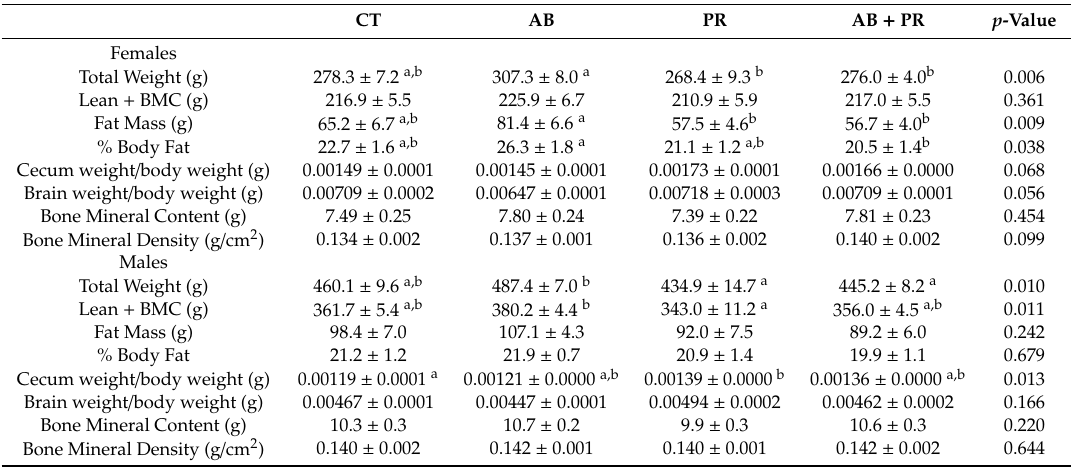
Table 1. Body composition and cecal and brain weight in female and male o ff spring at 10 weeks of age 1 .